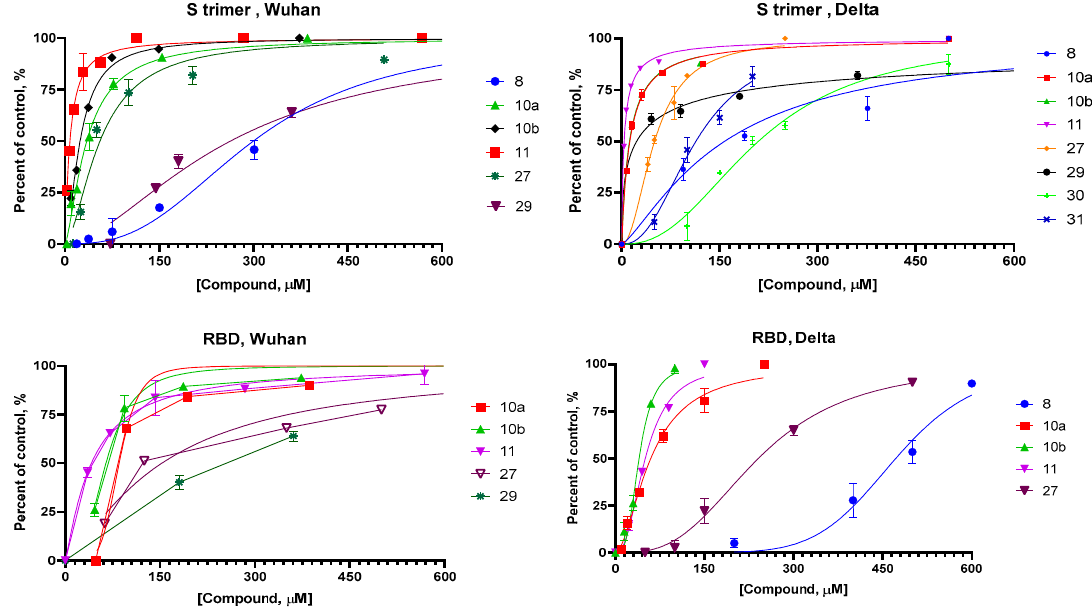
Figure 2. The inhibitory effect of compounds on SARS-CoV-2 RBD-Wuhan ( a ) and S trimer-Wuhan ( b ) binding to ACE2–HRP in our screening assay. Percent inhibition values obtained at 500 µ M concentration shown normalized to the control. Erythrosine B, Nb6 were included as positive controls. The color of the columns corresponds to the following class of compounds: green—arylamine, purple—arylmethane heterocyclic, blue—arylmethane dyes, orange—phthalein.